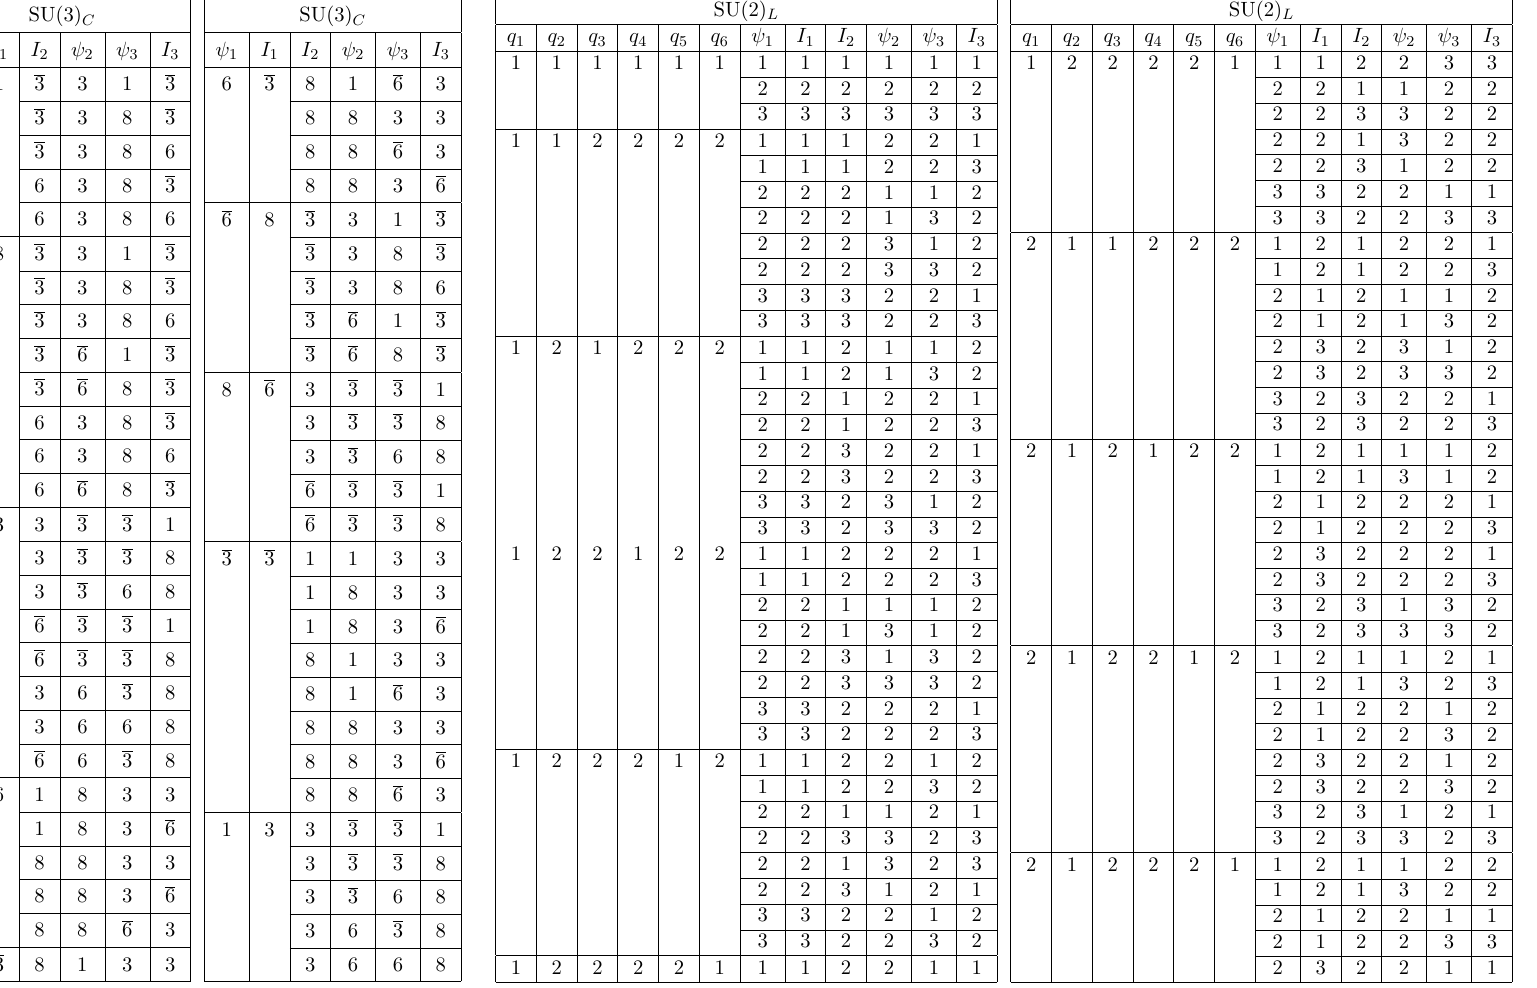
Table 11 . The possible SU(3) C and SU(2) L numbers of the fields in